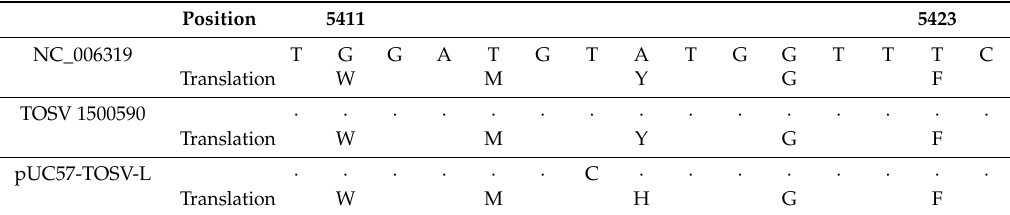
Table A2. A single nucleotide change was identified in L at position 5416 in the rescue plasmid when compared with both the TOSV reference sequence NC_006319 and TOSV 1500590.